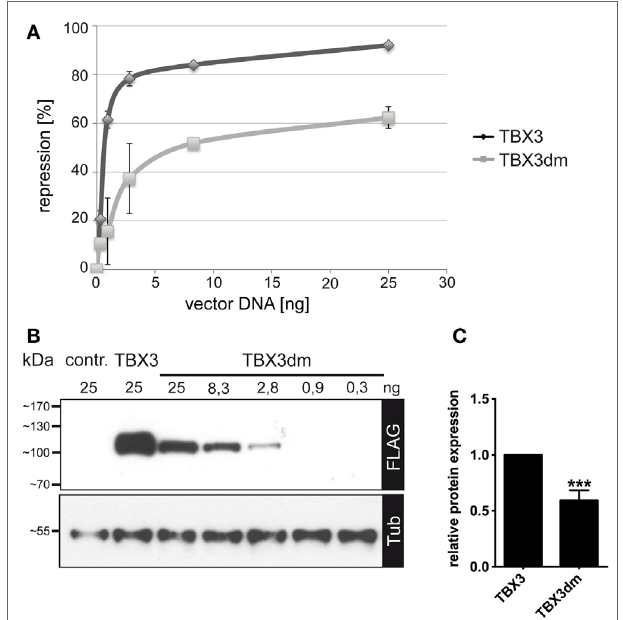
FigUre 3 | repression of p21-luc reporter by TBX3 and the Dna binding-deficient mutant TBX3dm . (a) Comparison of p21-Luc repression by TBX3 and TBX3dm in transfected COS-7 cells. In all assays, a total of 25 ng of the expression vector was used, with a varying ratio of empty to TBX vector. In the control, 25 ng of empty expression vector was transfected. Repression of the p21-Luc reporter was measured at six different concentrations of TBX3 or TBX3dm. Luc activity in the absence of TBX3 was defined as 0 repression ( n = 3). (B) Comparison of TBX3 and TBX3dm expression. TBX3dm expression is shown in a dilution series of its expression vector. Protein expression was visualized by Western blot of cell extract and FLAG immunodetection. Protein load was controlled with anti-alpha-tubulin. (c) Relative expression of TBX3 and TBX3dm. COS-7 cells were transfected with 25 ng expression vector ( n =